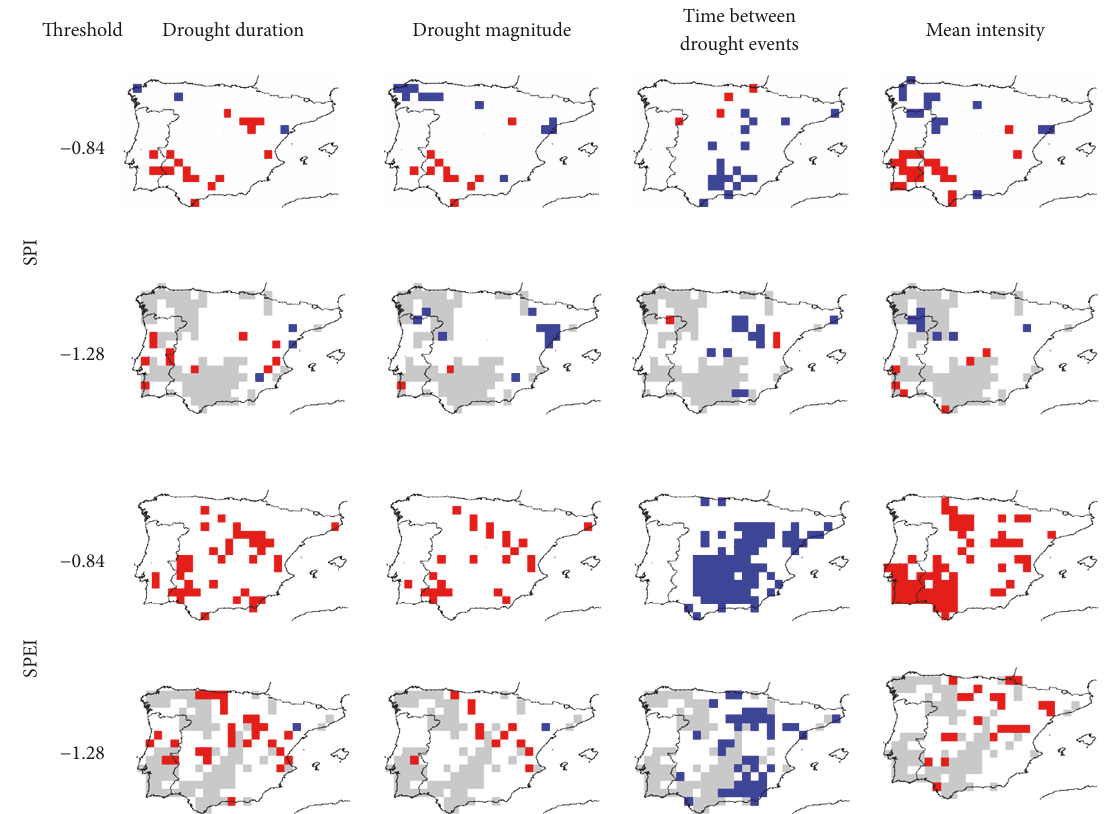
Figure 6: Significant trends in drought duration, drought magnitude, time between drought events, and mean intensity of droughts. Red (blue) grid points represent positive (negative) trends, and white represent no significant trend. Gray is used for the grid points where the time series of moderate/severe drought events has less than 20